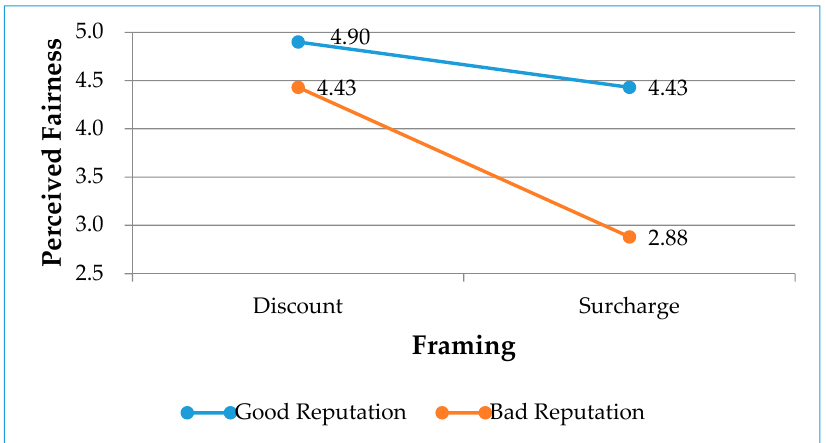
Figure 3. Interaction effects between reputation and framing on perceived fairness.